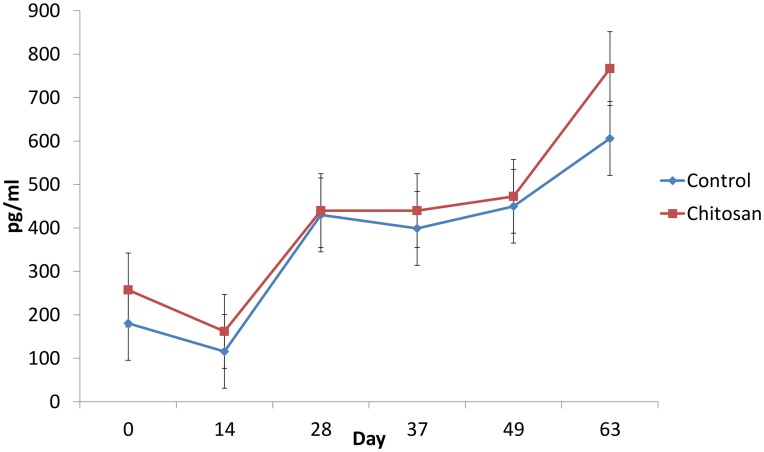
Effect of dietary supplementation on serum leptin levels over time at days 0, 14, 28, 37, 49 and 63.Treatment effect (P<0.05). Time effect (P<0.05). Values are means, with their standard errors represented by vertical bars.